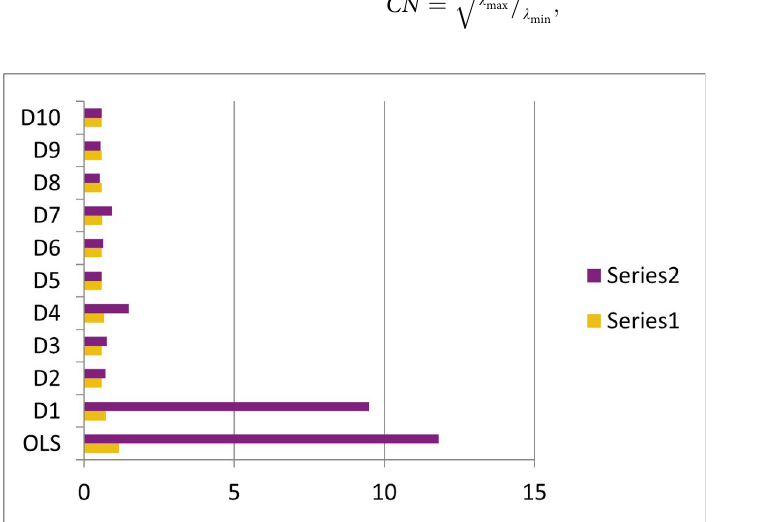
Fig 1. EMSE values for n = 25, p = 4 and ~ N